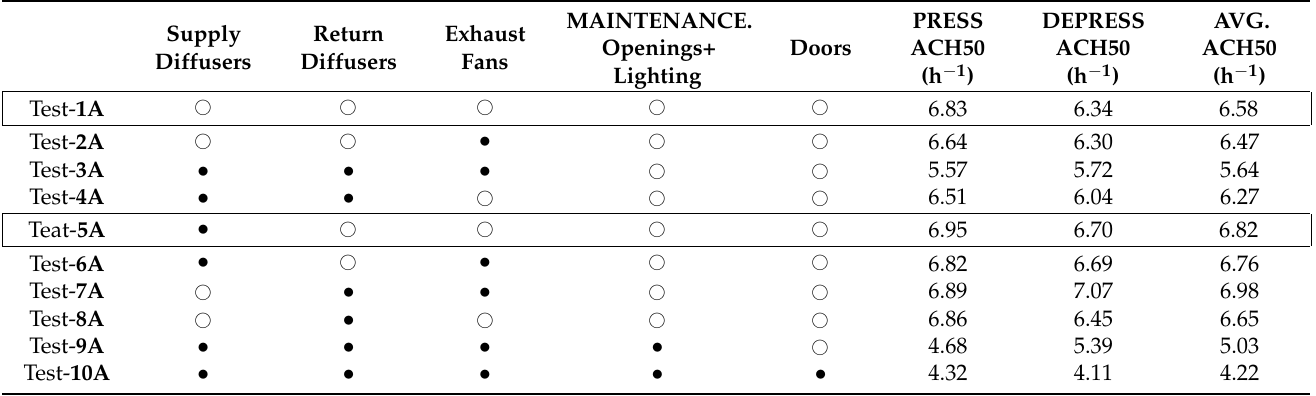
Table 3. Airtightness test results of House A.